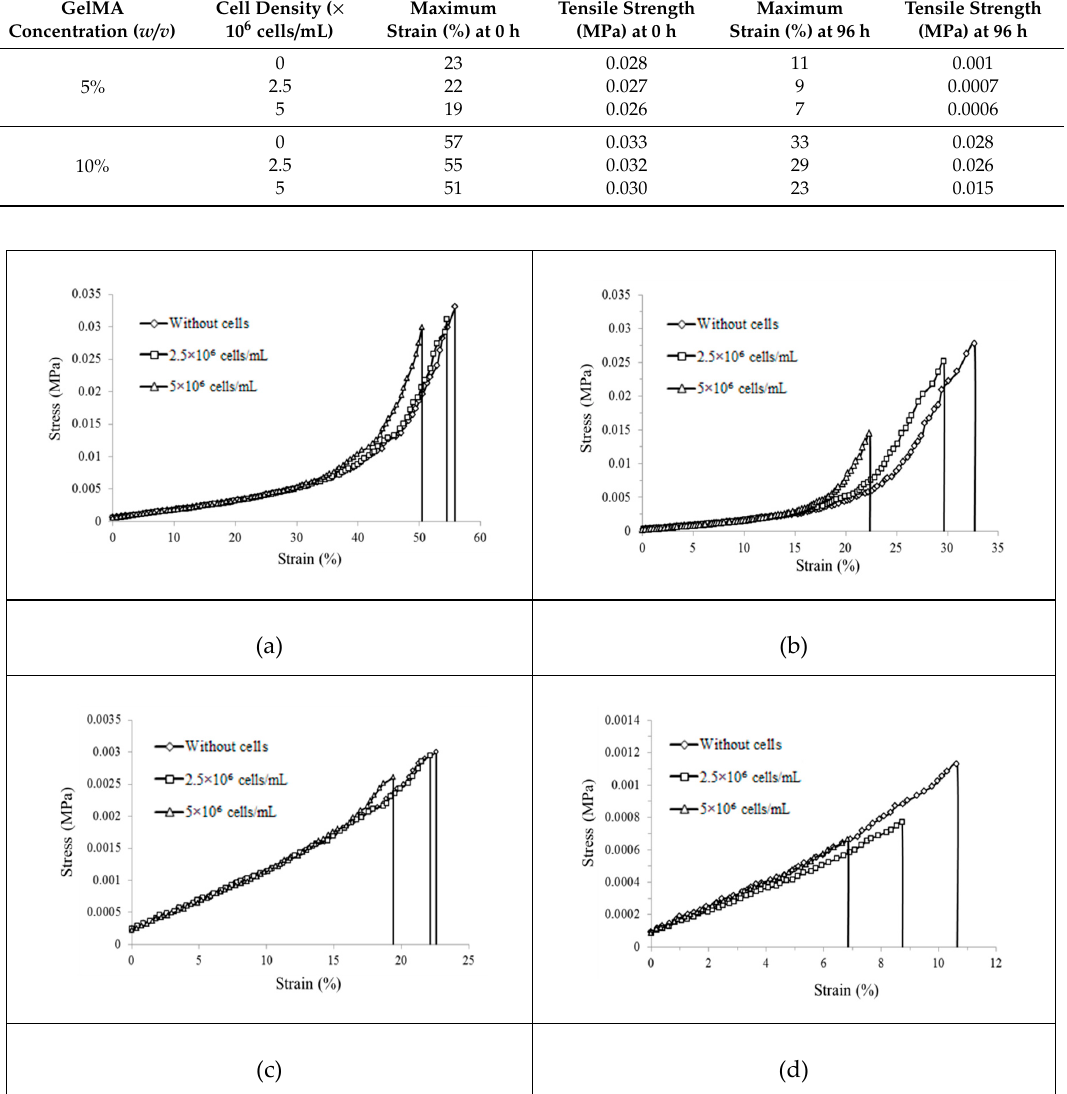
Figure 3. Stress–strain curves of the GelMA hydrogels with di ff erent GelMA concentrations at di ff erent incubation times: ( a ) 10% GelMA at 0 h, ( b ) 10% GelMA at 96 h, ( c ) 5% GelMA at 0 h, and ( d ) 5% GelMA at 96 h (a diamond represents without cells, a square represents 2.5 × 10 6 cells / mL, and a triangle represents 5 × 10 6 cells / mL).